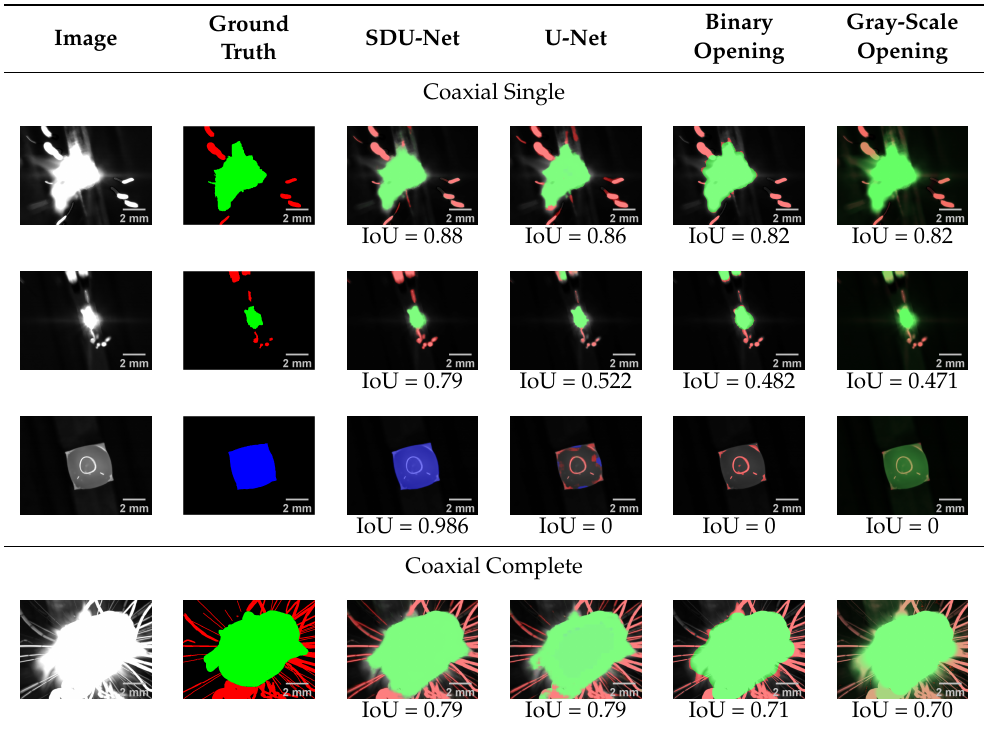
Table 3. Overlaid result images of the different methods. The green color marks the process light, red the spatters, and blue the cooling process. Average IoU value of the pixel which was assigned to process light, spatters, or cooling